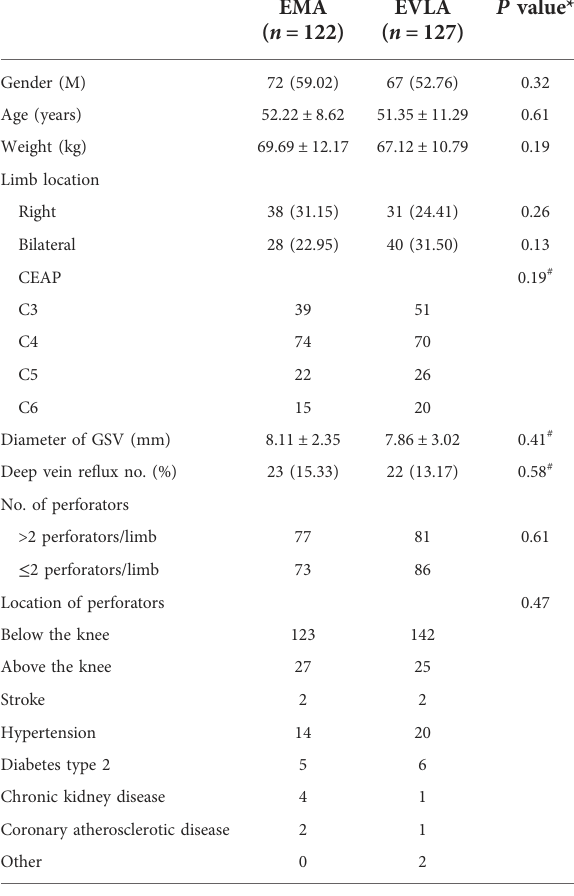
TABLE 1 Baseline data of the study participants in both procedures.